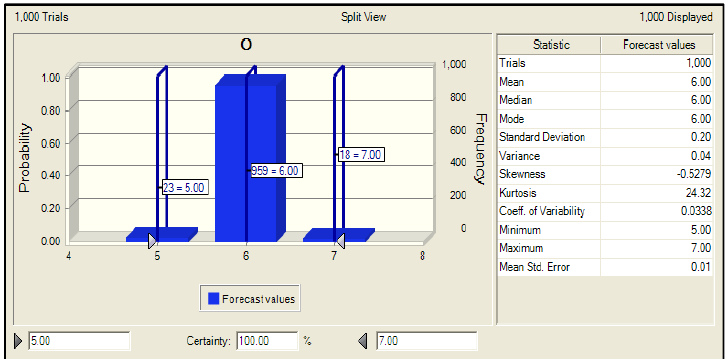
Figure 12. Case 1: Monte Carlo simulation of S in CB software.